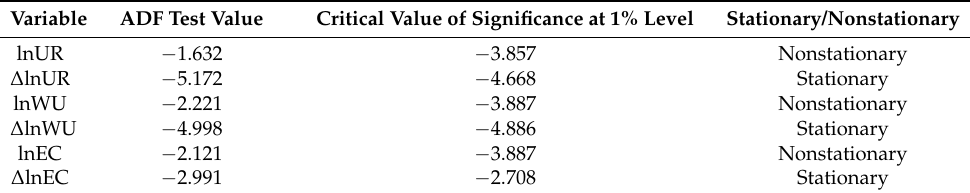
Table 1. Unit root test results.